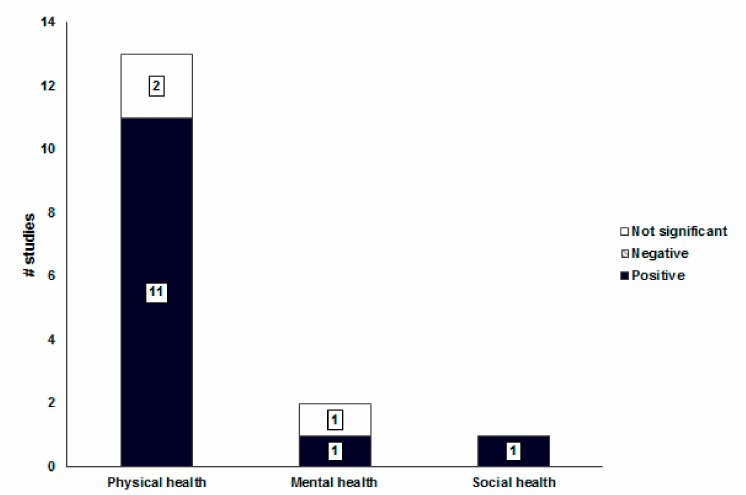
Figure 5. Associations between green and open spaces and health-related